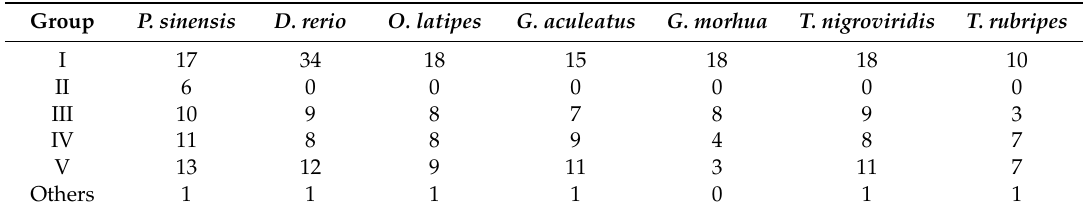
Table 1. Variation in number of CYP genes among P. sinensis and other fish species. Group